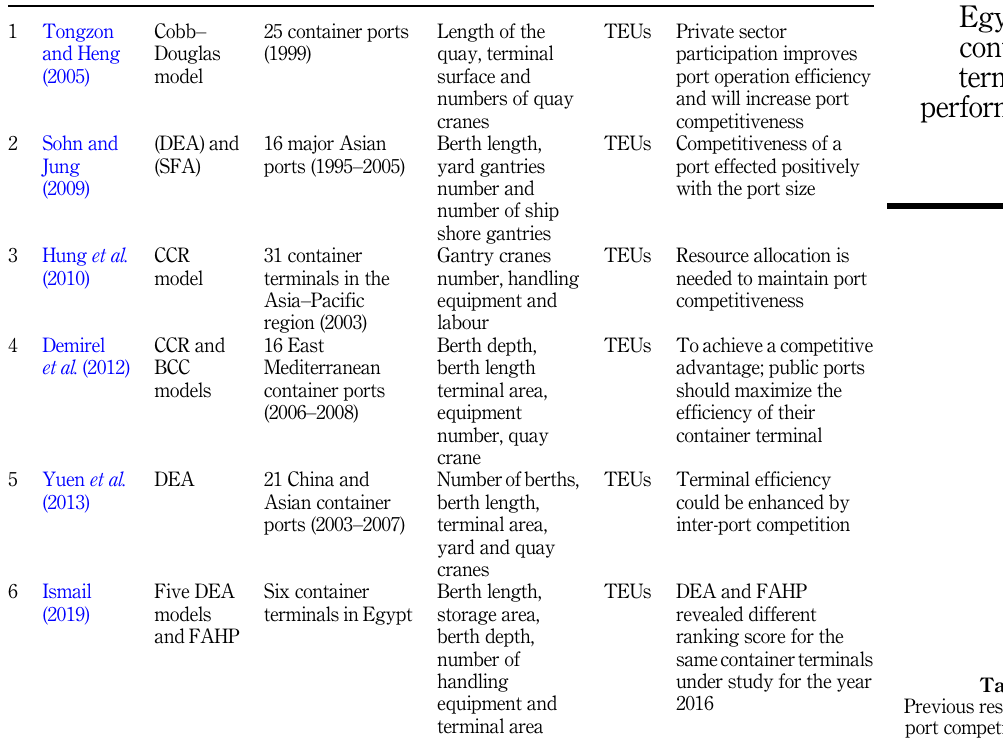
Table A2. Previous research